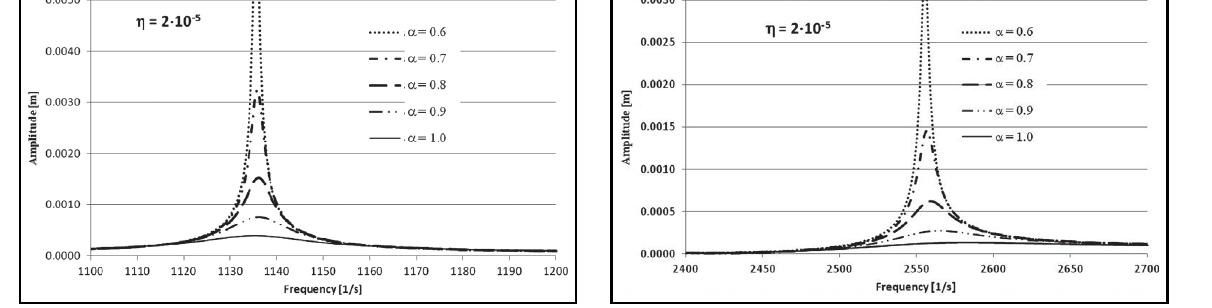
Fig. 4. Amplitude-frequency characteristic – 2-nd resonance. Fig. 5. Amplitude-frequency characteristic – 3-rd resonance.